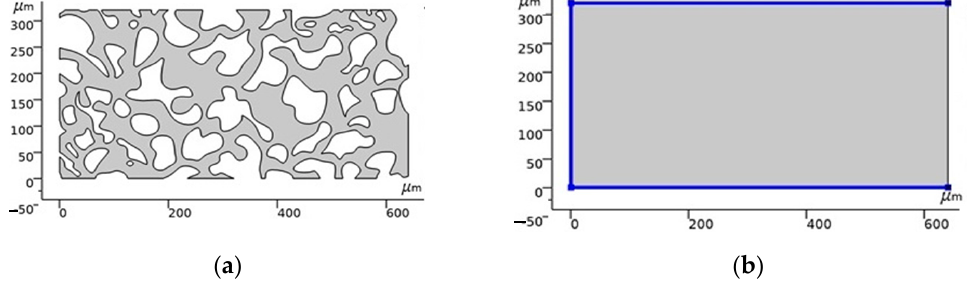
Figure 10. Geometry and boundary conditions of the reservoir (the color code is blue for 0 and red for 1 ). ( a ) Geometry of the reservoir; ( b ) boundary conditions of the